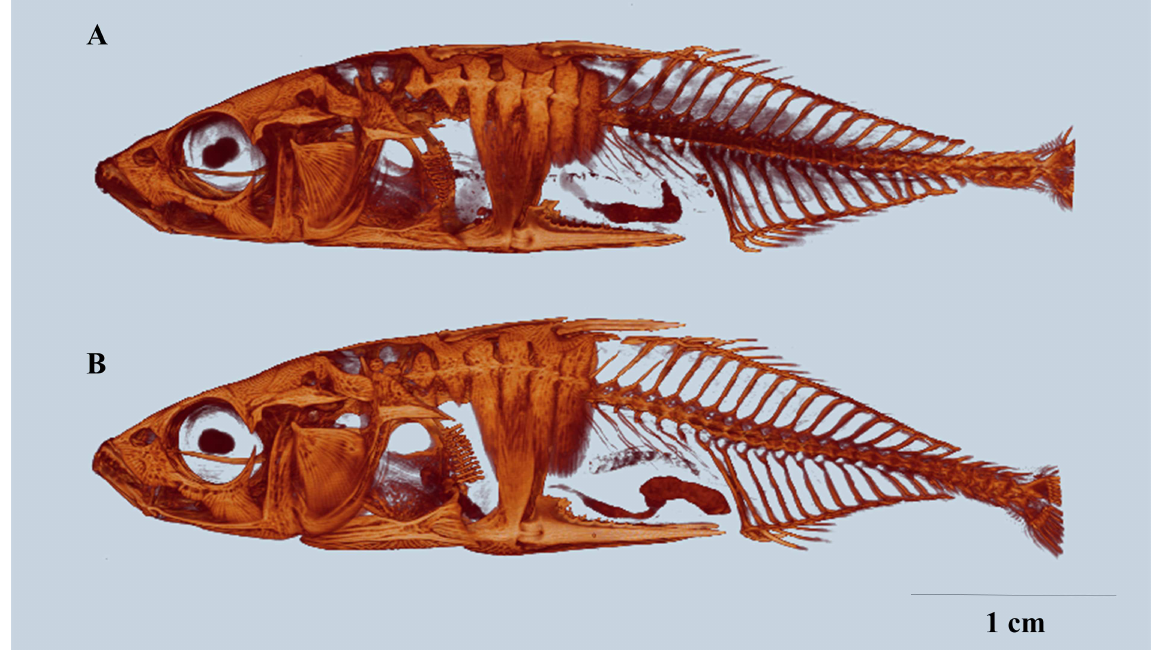
Fig 5. Partial plate morph morph from populationAsd ø ltjern(A) displayinglateral plates in the anterior region that appear reduced in height and width, in additionto loss of plates in the midsection and missing LP 1. Low plate morph from population Engervann(B) with only plates in the anterior region that appear reduced in height. Representative images for the populationsare